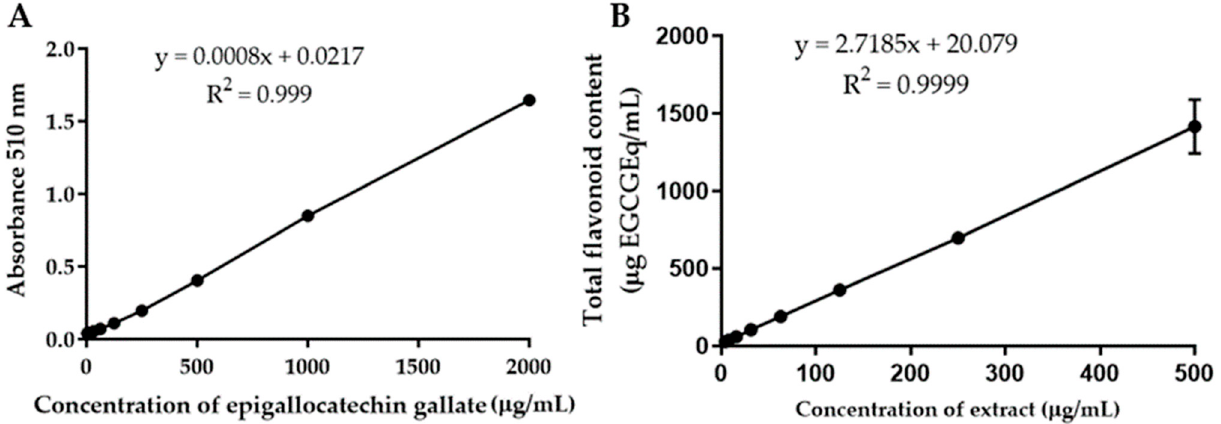
Figure 3. ( A ) Calibration curve of epigallocatechin gallate. ( B ) Total flavonoid content of B. flabellifer male flower ethanolic extract.